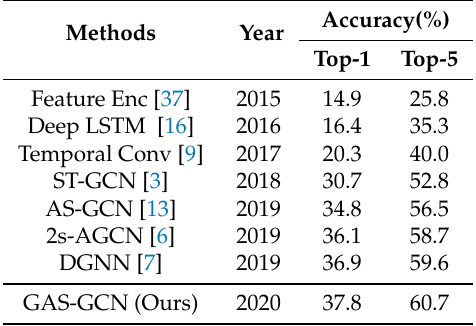
Table 2. Comparison with the state-of-the-art methods on Kinetics dataset. The top-1 and top-5 accuracy of the proposed method and other state-of-the-art methods are